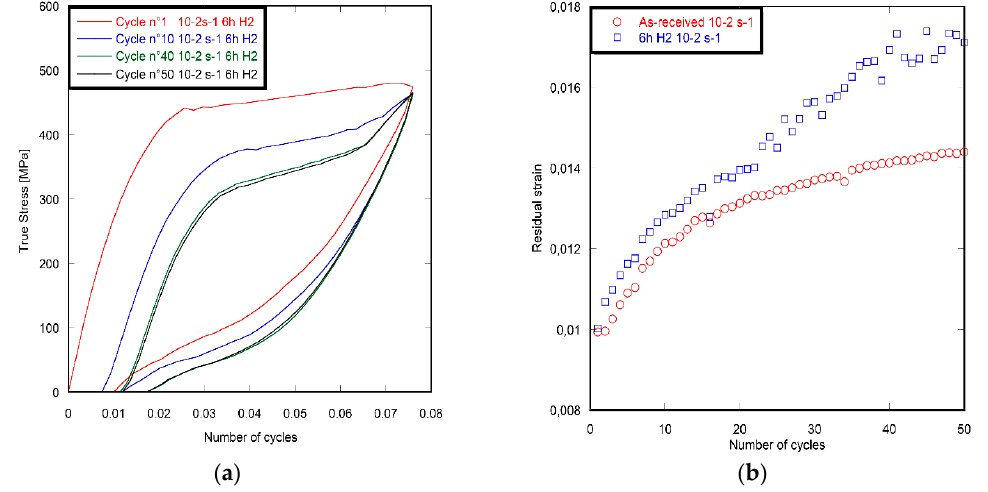
Figure 5. After 6 h of hydrogen charging and ageing ( a ) tensile loading and unloading with imposed strain rate of 10 − 2 s − 1 and ( b ) evolution of residual strain at zero stress as a function of number of cycles.